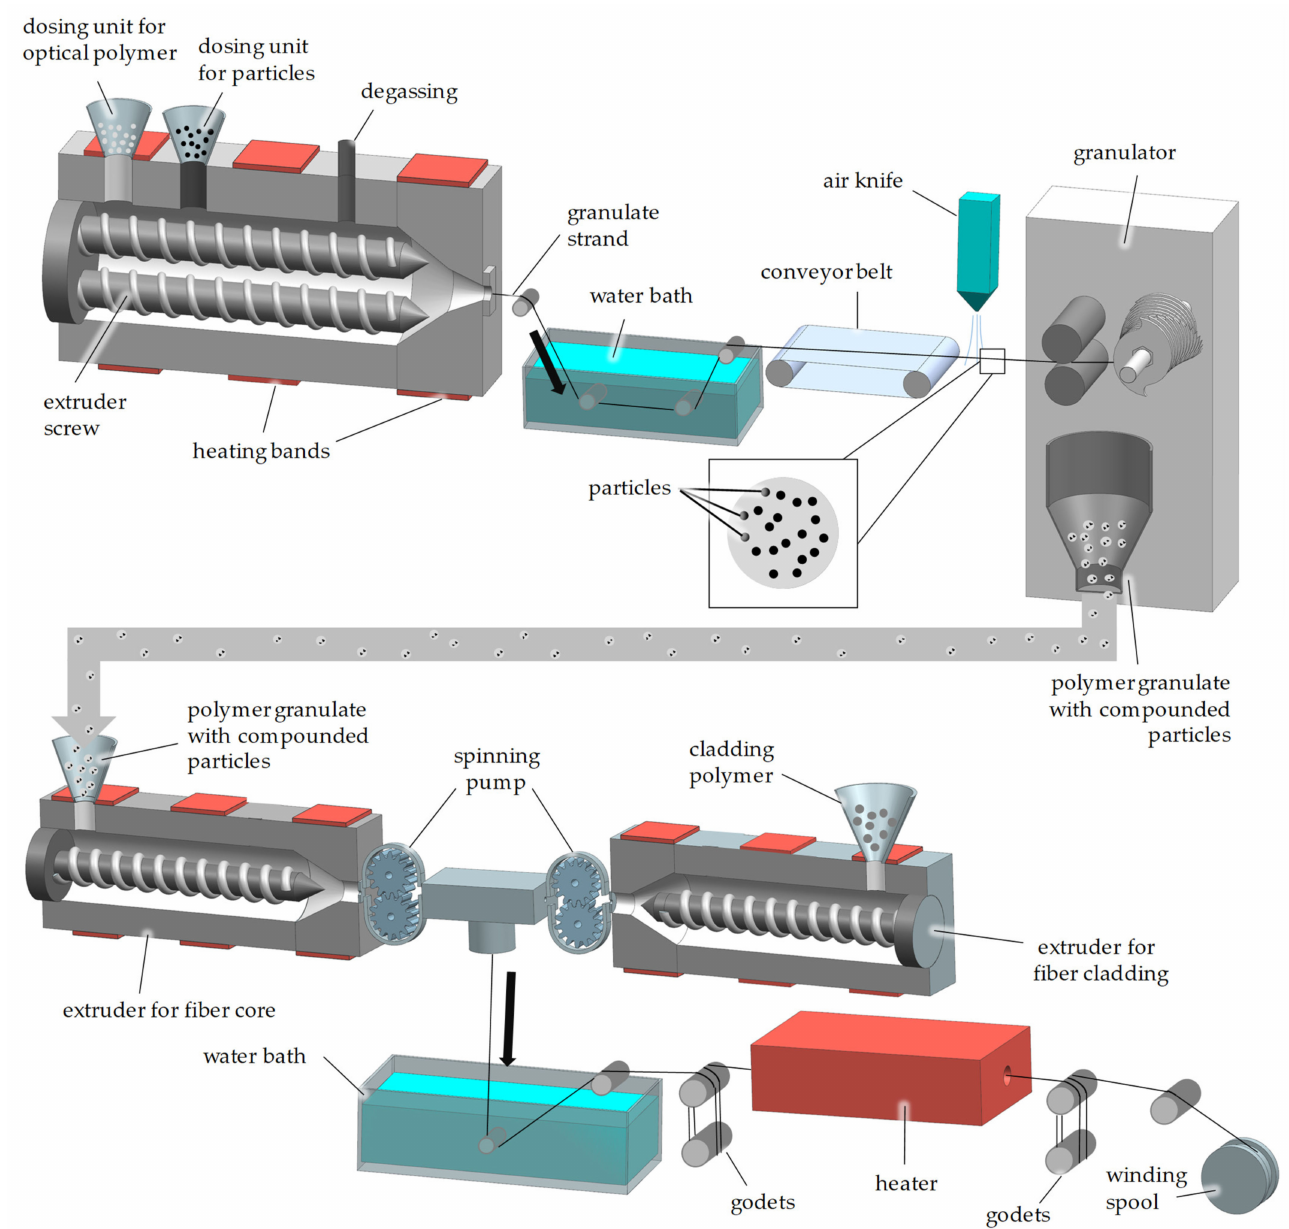
Figure 4. Production of a core-doped POF: compounding process of an optical polymer and scattering particles ( above ), bicomponent melt spinning process ( below